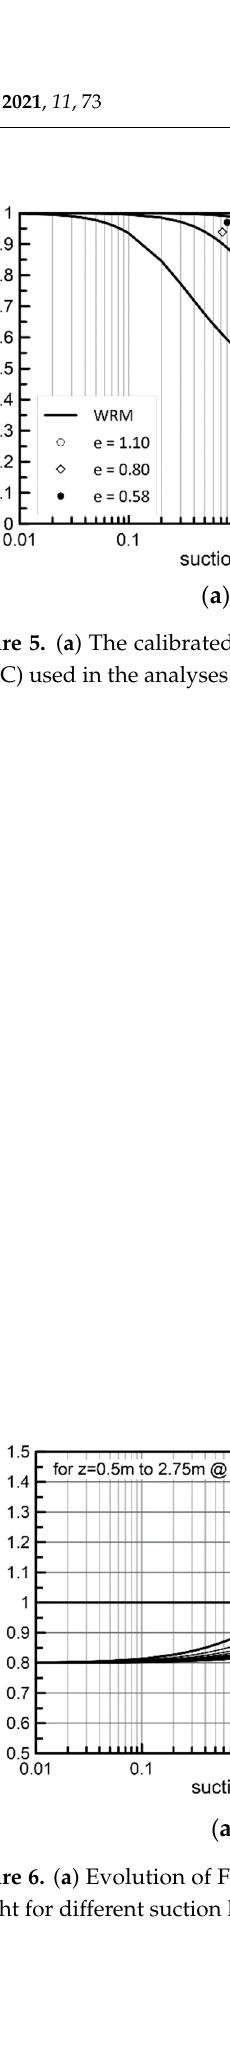
( b ) Figure 7. Stability chart; ( a ) stable vs. unstable suction and slope height combinations; ( b ) same as (a) in a semilogarithmic plot; results from a 2D mechanism (no lateral resistance). Examining the stability chart of Figure 6 in relation to the observed behaviour during the Ruedlingen field experiment, it seems that the suggested evolution of stability with suction and slope height does not match the observed behaviour. If we consider an aver- age slope height of 1.5 to 2 m, Figure 7 suggests that a minimum suction value of 10 to 15 kPa is required for stability. This may partially explain why the slope remains stable under the initial hydraulic regime which suggests a value of around 10 kPa, but at the same time it is obvious that even the smallest decrease in suction should cause failure. However, both in situ measurements [1] and numerical analyses [9] clearly indicate that even com- plete loss of suction is not enough to trigger the Ruedlingen failure. In this respect, it seems reasonable to assume that additional factors contribute to stability with respect to those examined with the present 2D failure mechanism.